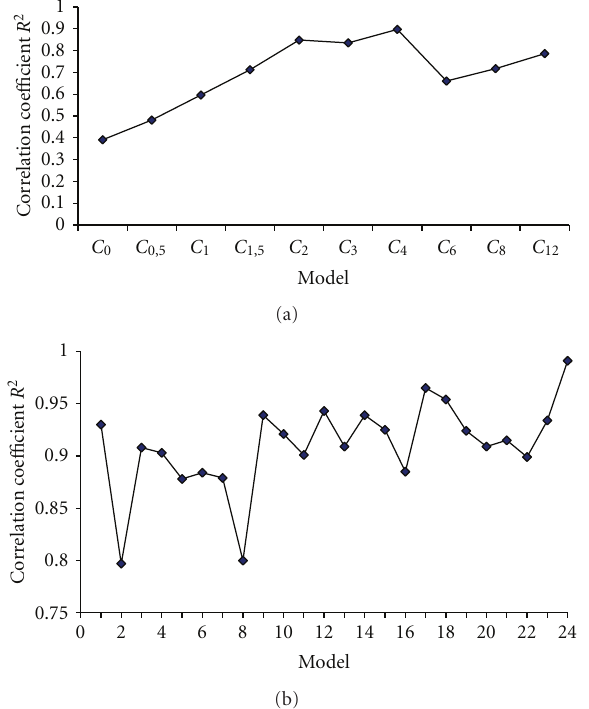
Figure 3: Evolution of Correlation coe ffi cients R 2 according select- ed models. (a) Correlation coe ffi cients between AUC 0–12h and CsA concentration at each time point. (b) Correlation coe ffi cients bet- ween AUC 0–12h estimated and concentrations at full hours.